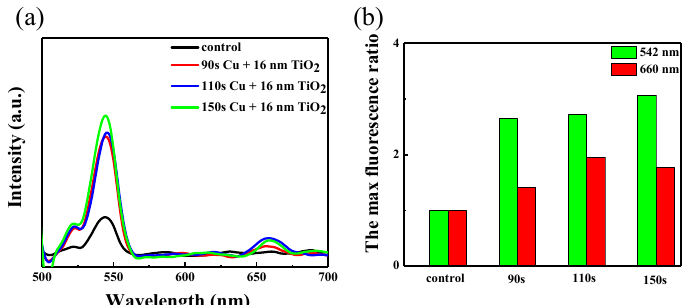
Figure 7. ( a ) Fluorescence spectra of NaGdF 4 :Yb, Er on the Cu/TiO 2 composite film. ( b ) Histograms of the maximum fluorescence intensity ratio between 542 nm and 660 nm emission.